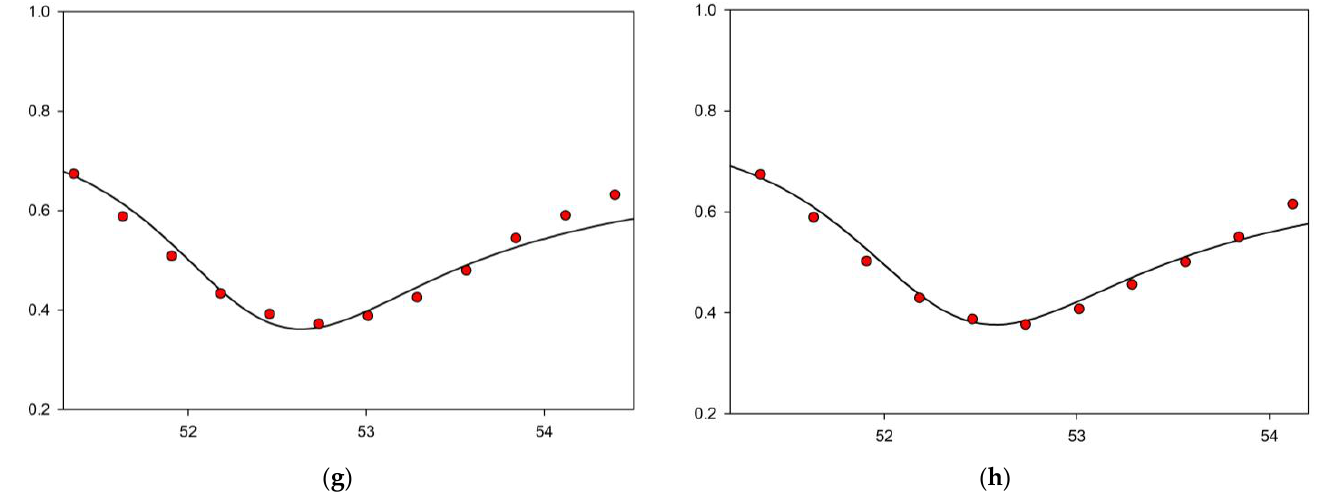
Figure 4. ( a ) Experimental SPR reflectivity curves related to CQD thin film exposed to different levels of DA solution; the experimental and fitted curves of the sensor film exposed to ( b ) 0 fM, ( c ) 1 fM, ( d ) 10 fM, ( e ) 100 fM, ( f ) 1 pM, ( g ) 10 pM, and ( h ) 100 pM of DA.